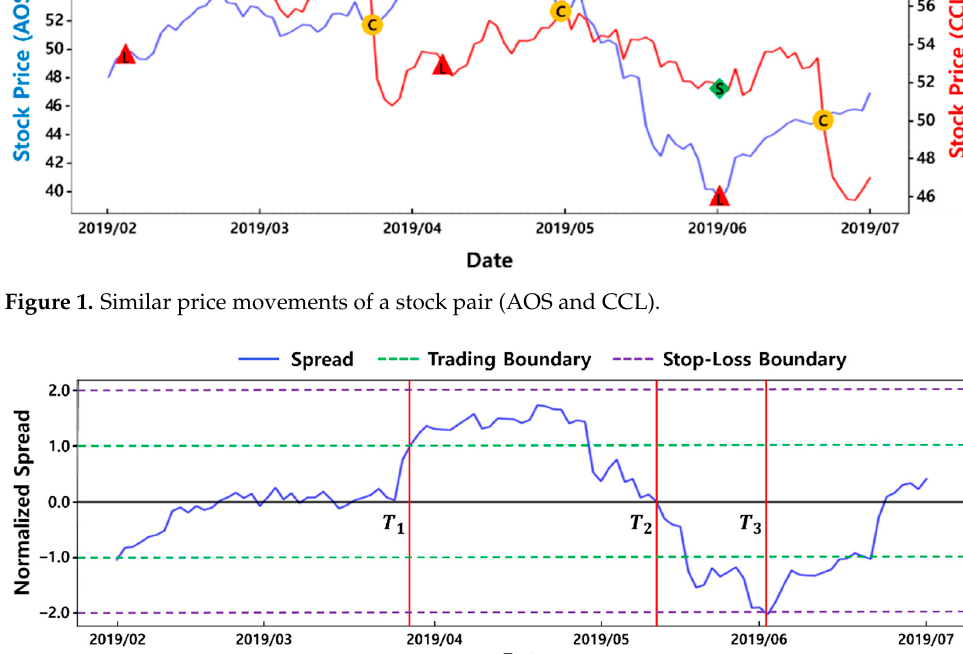
Figure 1. Similar price movements of a stock pair (AOS and CCL).